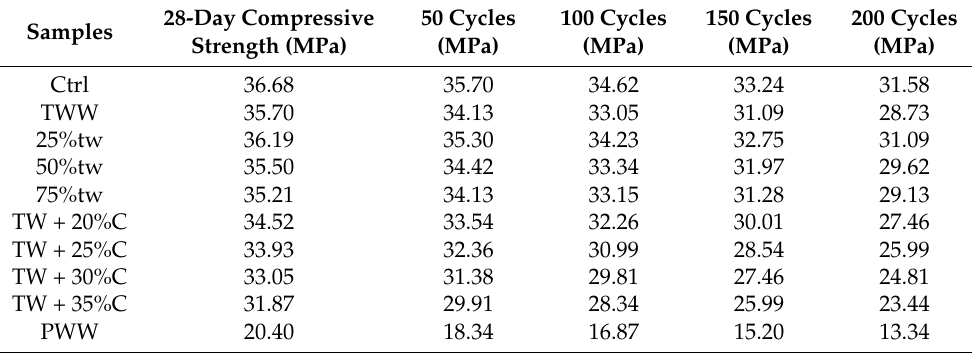
Table 8. The results of resistance of concrete to rapid freezing and